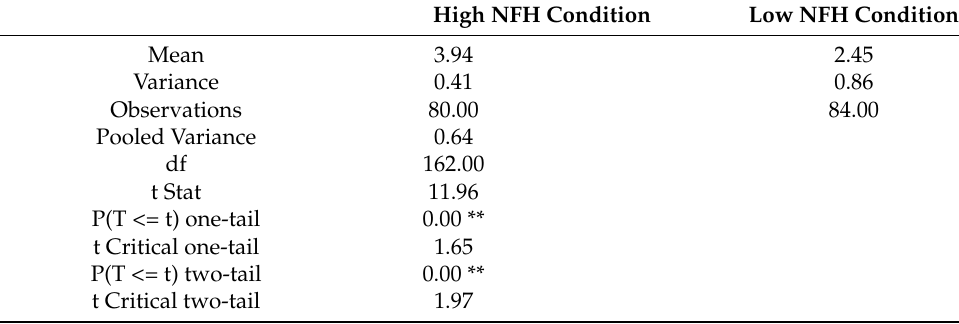
Table 7. Study 2a Manipulation